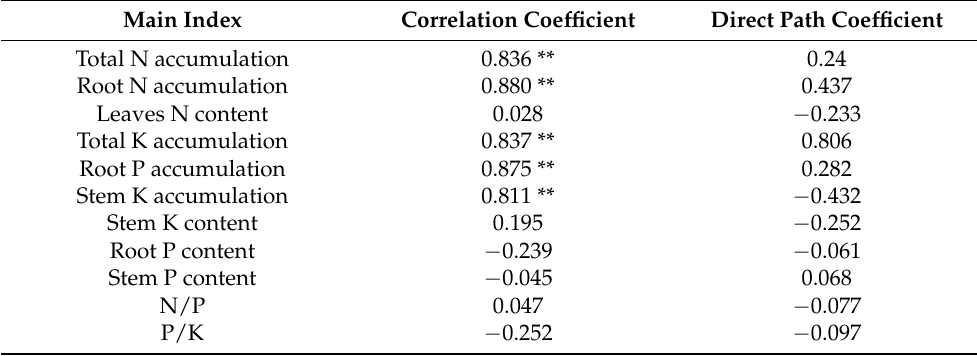
Table 9. Path coefficients between main indices and total dry biomass of P . bournei seedlings under N-P-K fertilization.